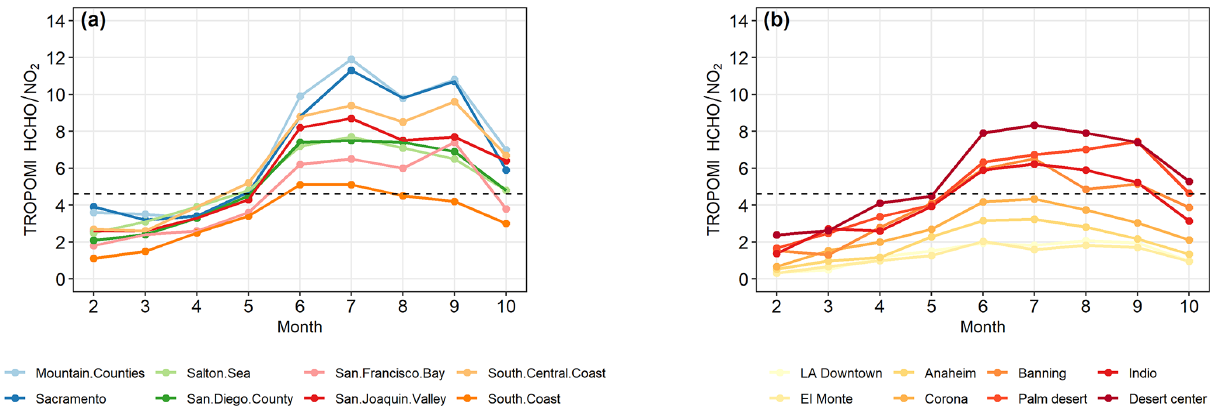
Figure 10. Monthly variation of TROPOMI HCHO / NO 2 in different air basins (a) and in different cities in Southern California (b) . The darker colors in the right panel indicate increasing distance from the urban center of Los Angeles.